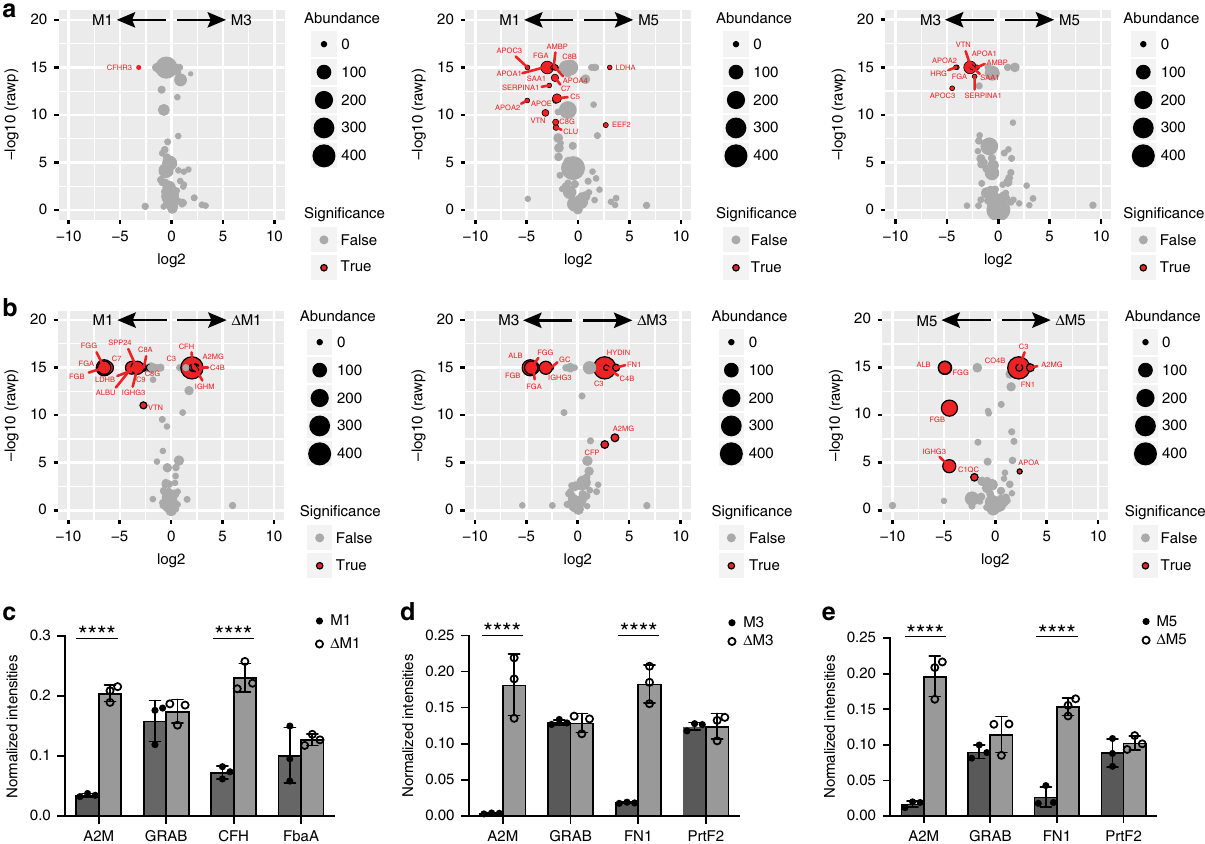
Fig. 4 Plasma protein interactomes of S. pyogenes M1, M3, and M5 serotypes. a Volcano plots comparing the plasma interactomes of the different M protein serotype strains, and b volcano plots of the different M protein serotypes compared to their respective M protein deletion strains. In a , b human proteins are indicated that do (red sphere) and do not (gray sphere) show a signi fi cant difference in the compared interactomes. The data was fi ltered using a log2 fold enrichment of >2 and an adjusted P- value < 0.05 using the Welch ’ s t -test. The size of the spheres indicates protein abundance as measured in SA – DIA. c – e Quantitative Baccus peptide-based 8 SRM-MS comparison between the different M protein serotypes as compared to their respective M protein deletion strains. Here we compare the interaction with human alpha-2-macroglobulin (A2M) in relation to the amount of expressed streptococcal protein GRAB, the amount of complement factor H (CFH) and fi bronectin (FN1) in relation to fi bronectin-binding proteins (FabA and Prtf2). Two-way ANOVA of the data indicates that there is a signi fi cant difference in the binding of the human proteins between the different strains as indicated by four asterisks P < 0.0001 using Sidak ’ s multiple comparison test and n = 3 biologically independent samples. Error bars are expressed as standard deviation (s.d.) from the mean. Source data are provided as a Source Data fi